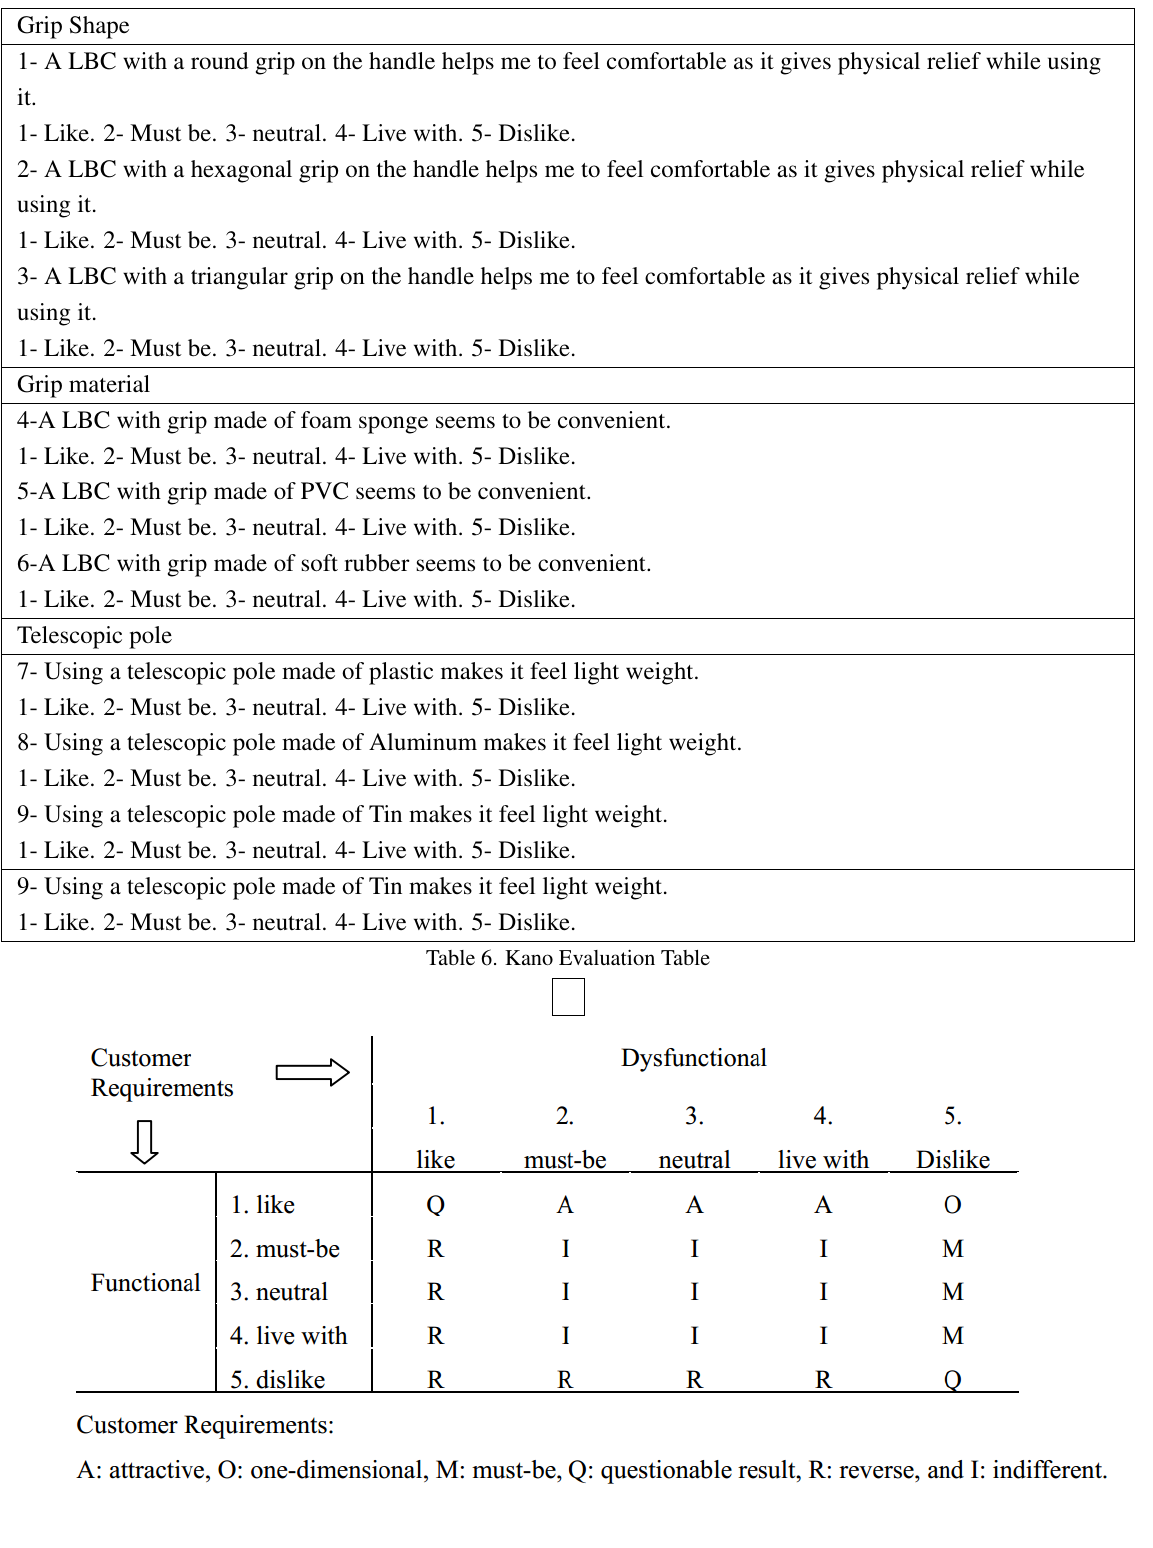
Table 5. An example of functional questions in the Kano questionnaire